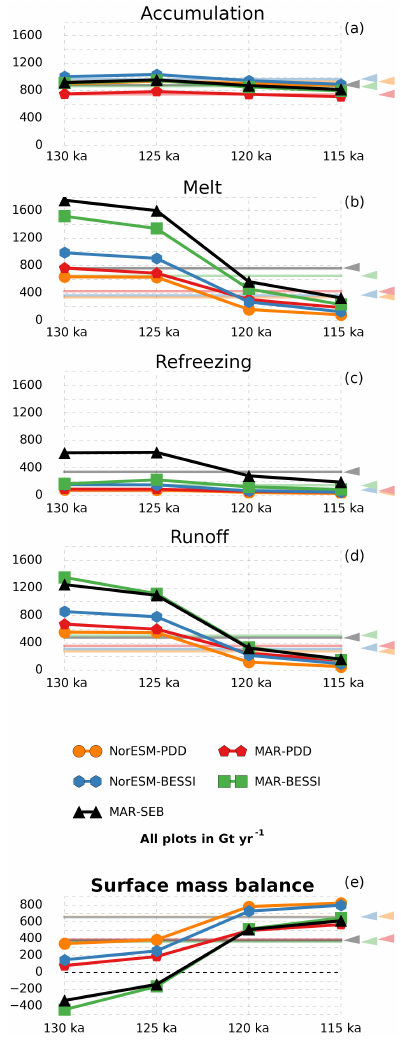
Figure 13. Eemian evolution of the SMB components (integrated over grid cells with more than 50% ice cover in MAR; Gtyr − 1 ). Pre-industrial values for each model are shown as shaded lines in the background and as triangles on the